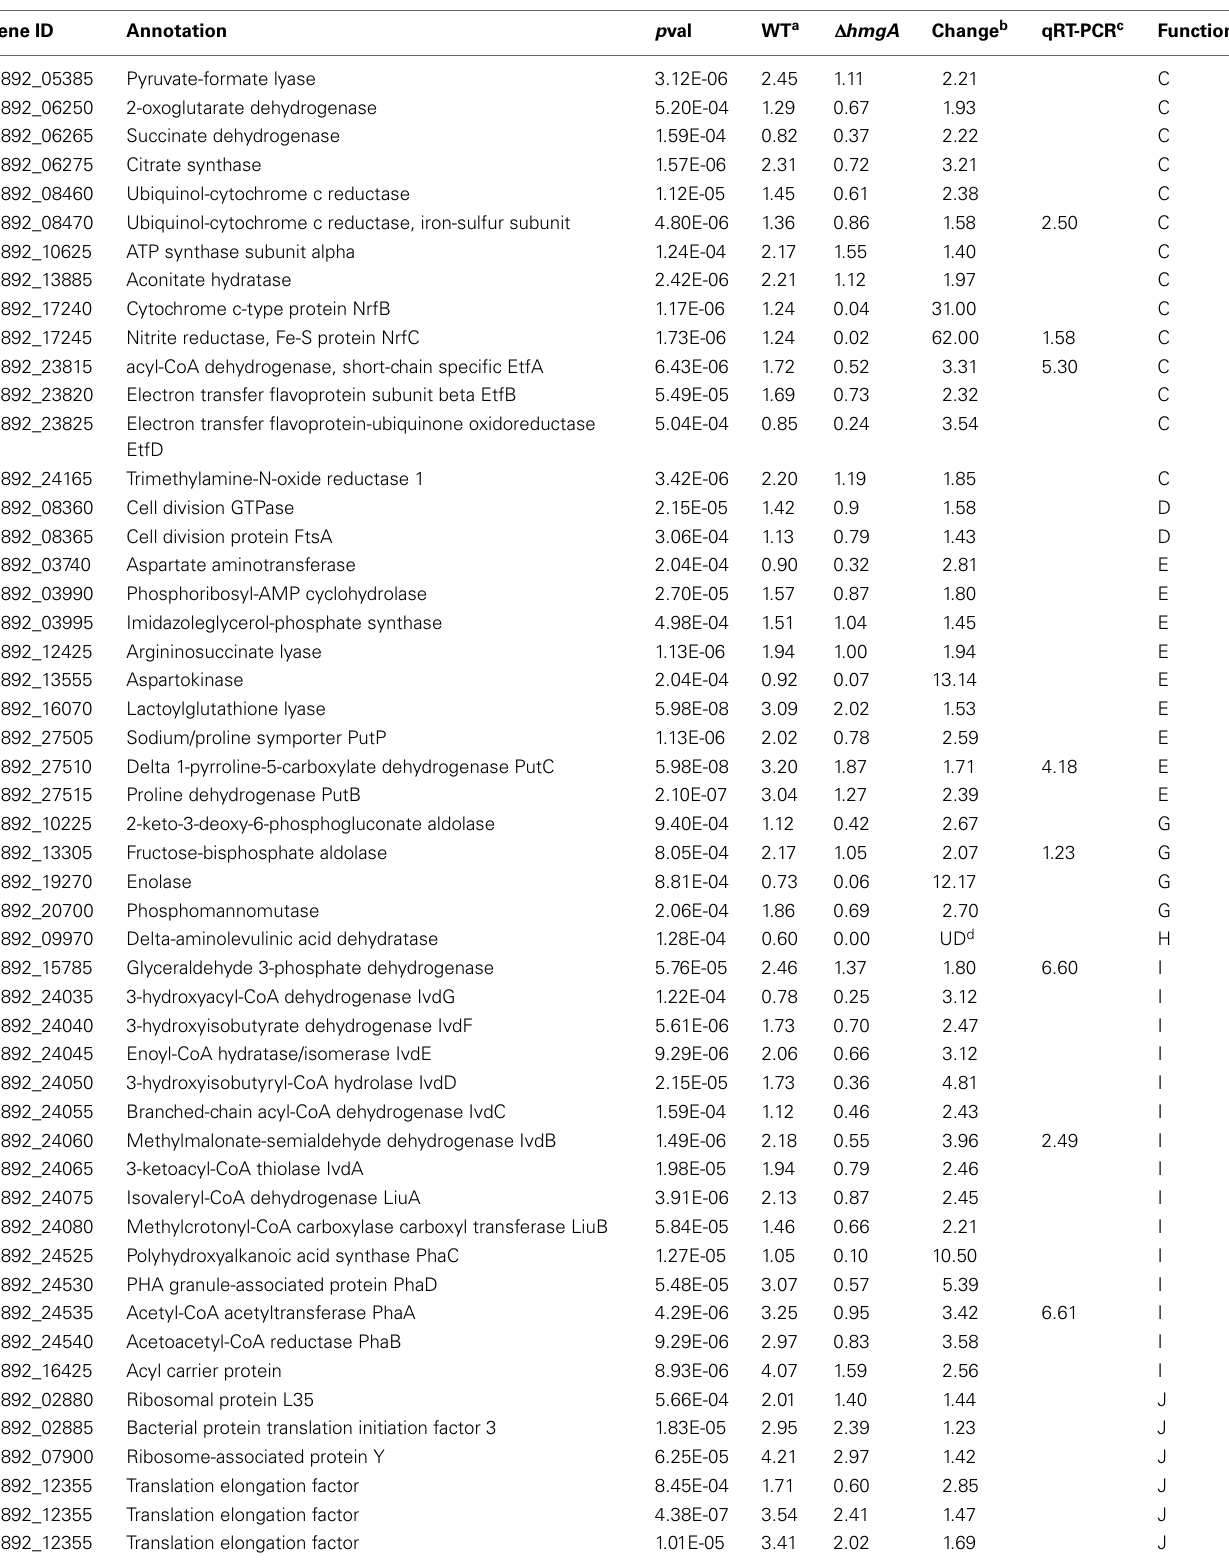
Table 2 | Differentially expressed genes in (cid:2) hmgA compared with WT V. campbellii . Gene